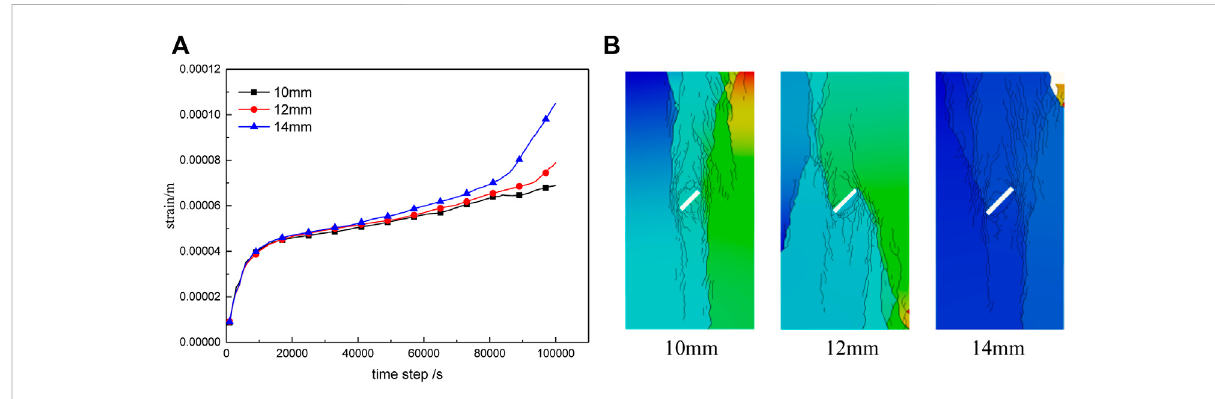
FIGURE 9 Creep curves (A) and rupture diagrams (B) for different fracture